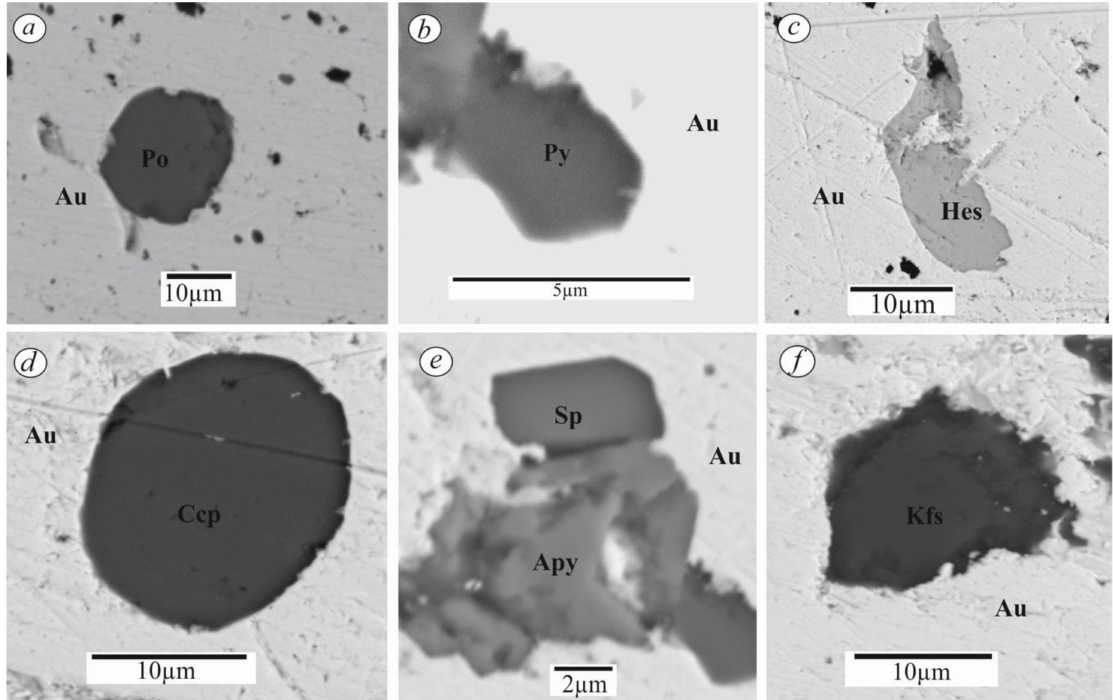
Figure 3. Mineral inclusions in the placer gold from the Borosku Unguokhtakh Creek: ( a ) a rounded pyrrhotite (Po) grain; ( b ) a small pyrite (Py) crystal; ( c ) an irregularly shaped hessite (Hes) grain; ( d ) an oval chalcopyrite (Ccp) grain; ( e ) sphalerite (Sp) and arsenopyrite (Apy) intergrowth; ( f ) K-feldspar (Kfs). Images have been taken in BSE mode. Conventional symbols of minerals have been taken from